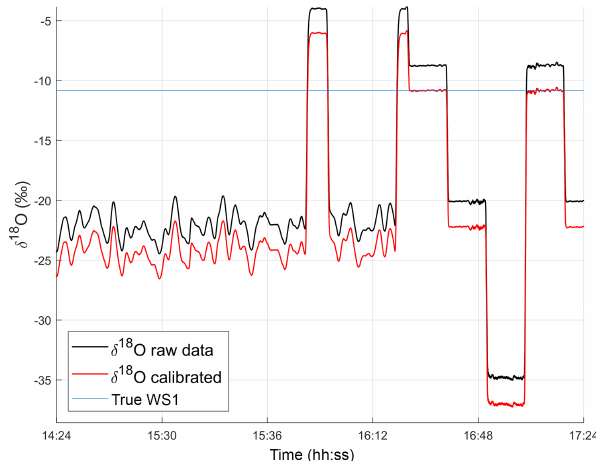
Figure 6. Representative δ 18 O calibration of ice core stack and WS1, using RICE and ITASE standards from the same cycle, 15s moving average vs. time (measured on 2 July 2014). The difference between the true value of WS1 (blue) and the calibrated measured value of WS1 (red) is the calibration error. The error that was ap- plied to the CFA data set is the average difference of all WS1 cali- bration measurements during the melting